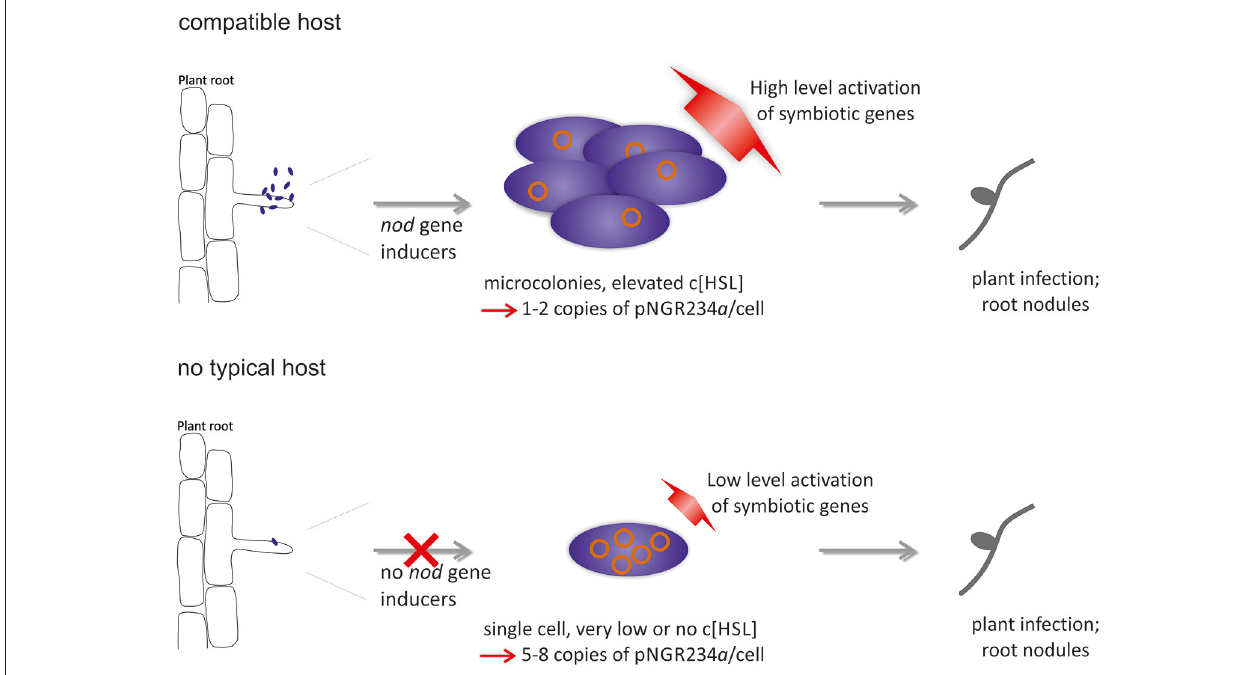
FIGURE 5 | Possible model of alternative nod gene induction in Sinorhizobium fredii NGR234 and related broad host range rhizobia. Image in the upper panel depicts the classical nod gene-inducing pathway, during which plant phenolic compounds and betaines are required as signals for induction of genes with relevance to plant infection and symbiosis. Once the signal is perceived Nod factors are produced and root nodule formation can be initiated. The lower panel describes a simpler pathway that is employed if no compatible host is found and if only single cells are attached to the root hairs. Under these conditions, the absence of autoinducer molecules triggers an increase in copy number of the symbiotic replicon from 1 copy to 5–8 copies per cell. This in turn results in a low level transcription of all genes located on the symbiotic plasmid and allows the production Nod factors and T3SS effectors.